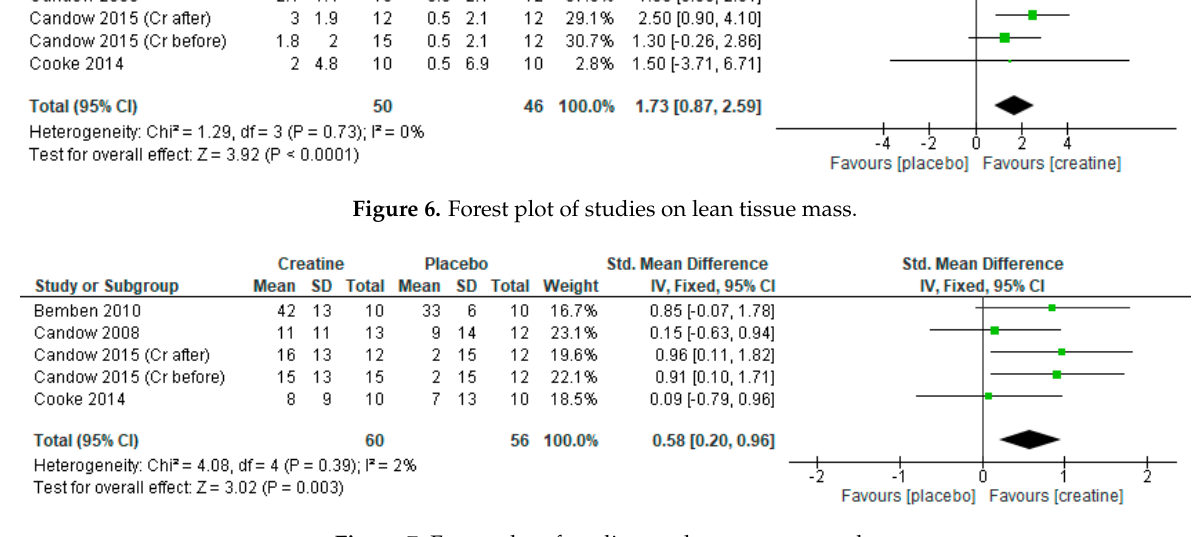
Figure 7. Forest plot of studies on chest press strength.